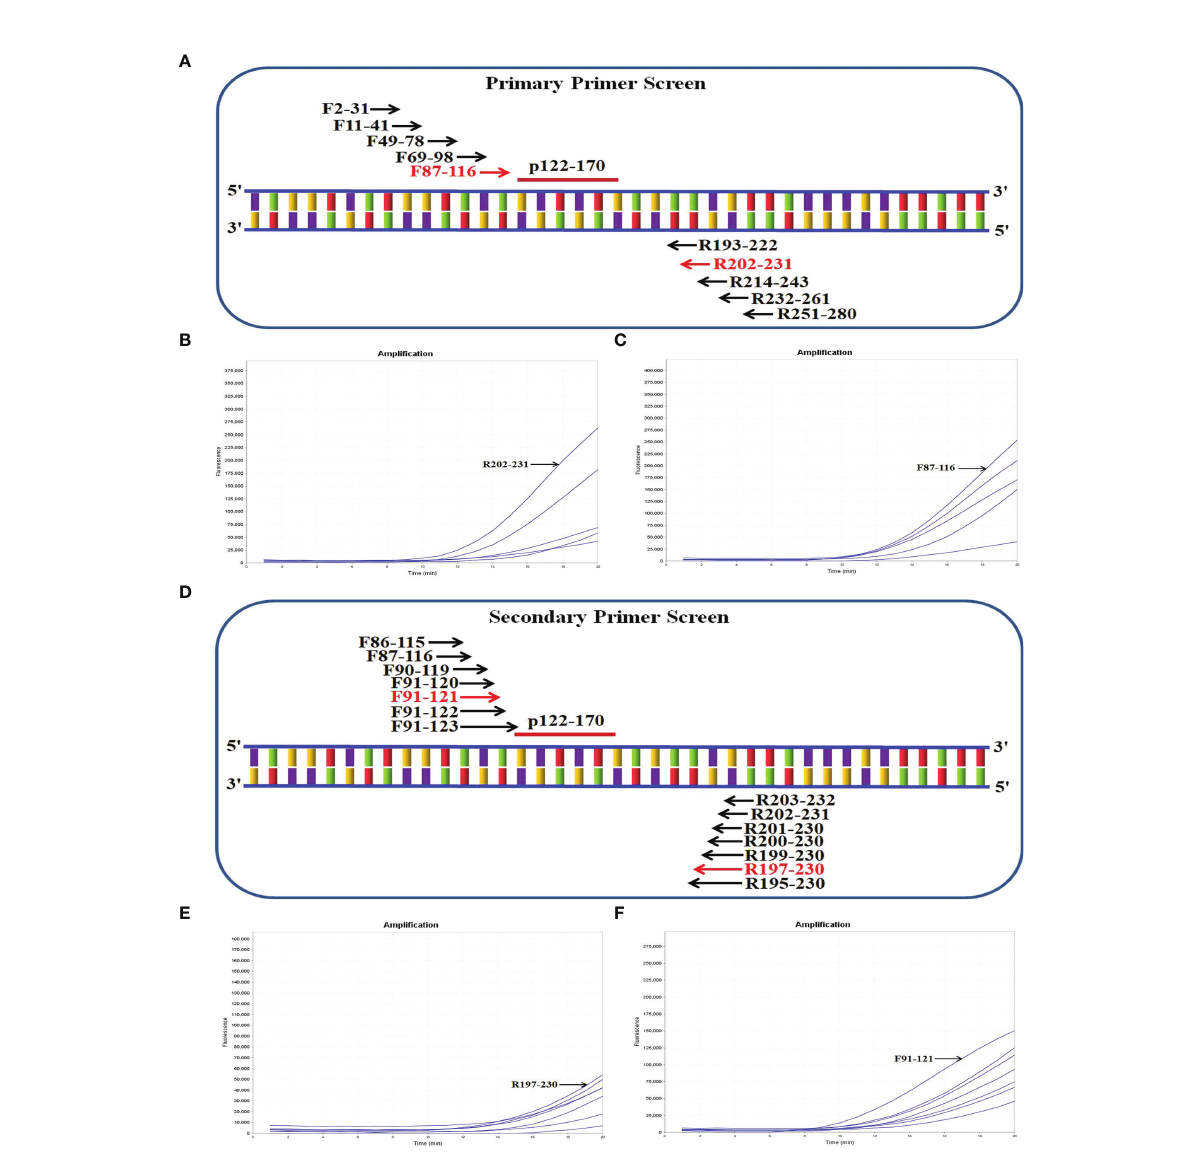
FIGURE 2 Screening the optical primers for real-time RT-RAA detection. (A) Sketch map of primary primer screening. In the primer name, the numbers indicate the position within the M gene from H1N1 (GenBank accession no. KX879560.1). (B) Primary reverse primer screening results. The forward primer F2-31 was randomly selected to screen all fi ve reverse primers. (C) Primary forward primer screening results. The picked reverse primer R202-231 was used to pick all fi ve forward primers. (D) Sketch map of secondary primer screening. (E) Secondary reverse primer screening results. The picked forward primer F87-116 was applied to screen all seven reverse primers. (F) Secondary forward primer screening results. The picked reverse primer R197-230 was used to pick all seven forward